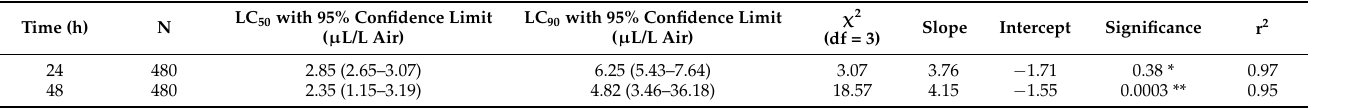
Table 2. Results of probit analyses of the data obtained from a fumigant toxicity assay of Eucalyptus largiflorens essential oil against the adults of Callosobruchus maculatus.